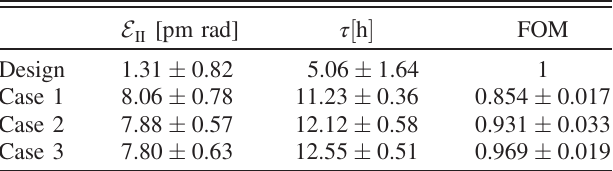
TABLE III. Tracking results for Touschek lifetime along with FOM for each case. Mean value and standard deviation are given for 10 error